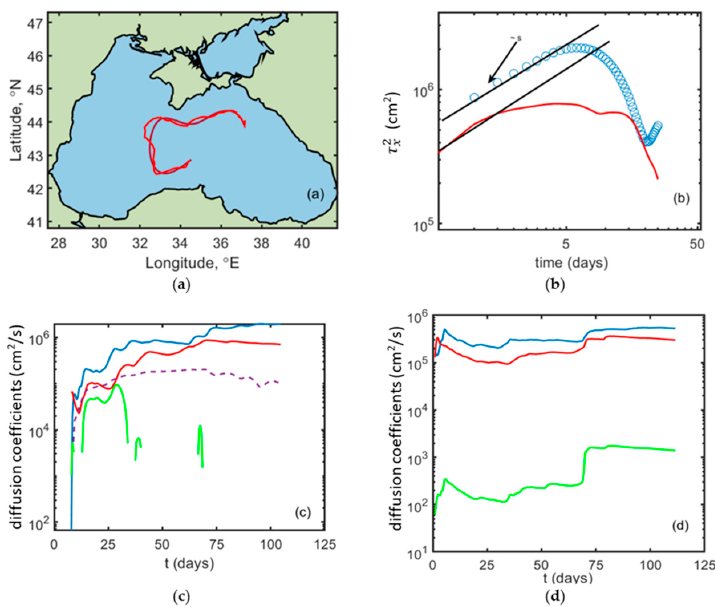
Figure 6. Time dependence of the second moments of time-averaged mean square displacements and